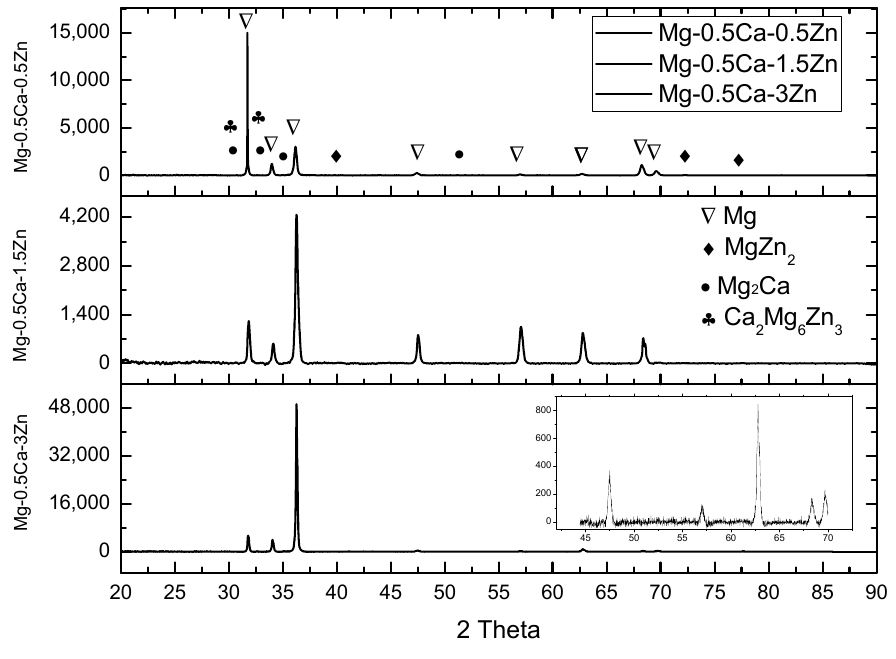
Figure 4. XRD pa tt erns of the Mg–0.5Ca–xZn biodegradable alloys. Figure 4. XRD patterns of the Mg–0.5Ca–xZn biodegradable alloys. Table 2. Chemical composition results by the Bruker EDS method. Table 2. Chemical composition results by the Bruker EDS method.